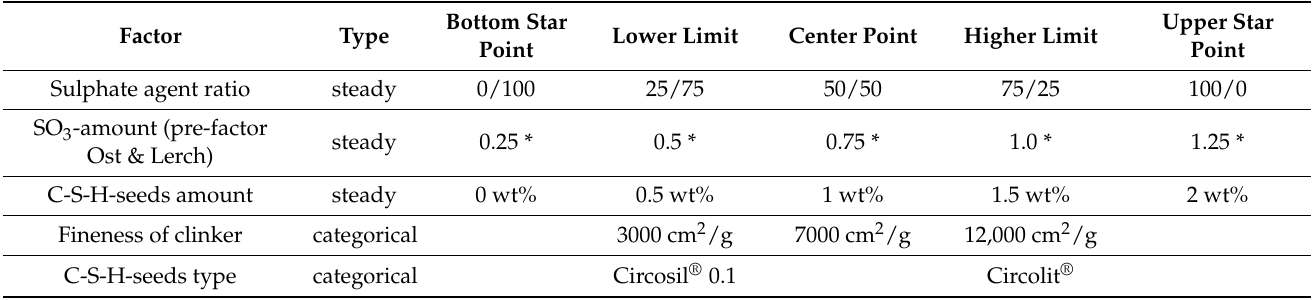
Table 3. Influencing factors to accelerate the hardening process that were varied by DoE in this study. Bottom Factor Type